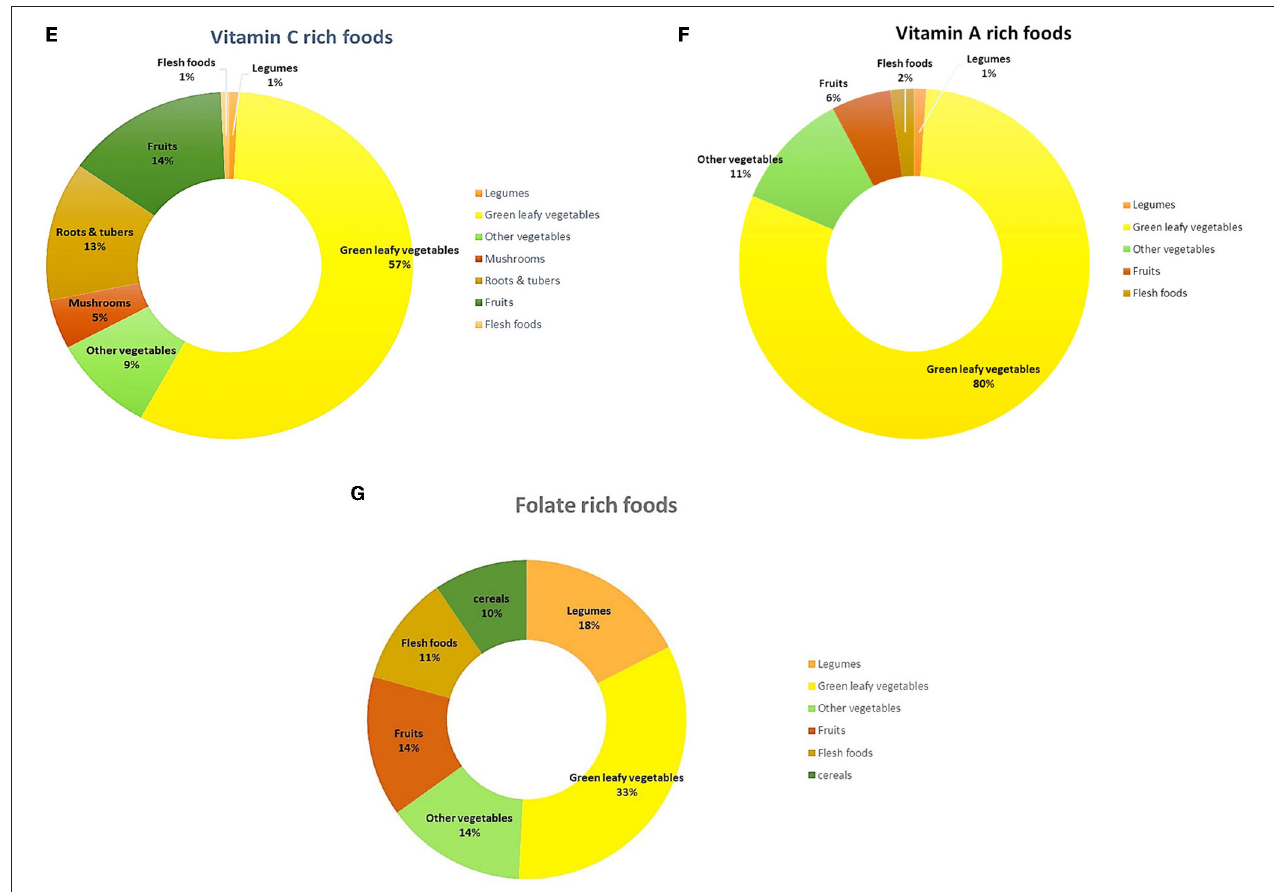
FIGURE 2 | (A–G) Distribution of protein and micronutrient-rich indigenous foods in each food group.